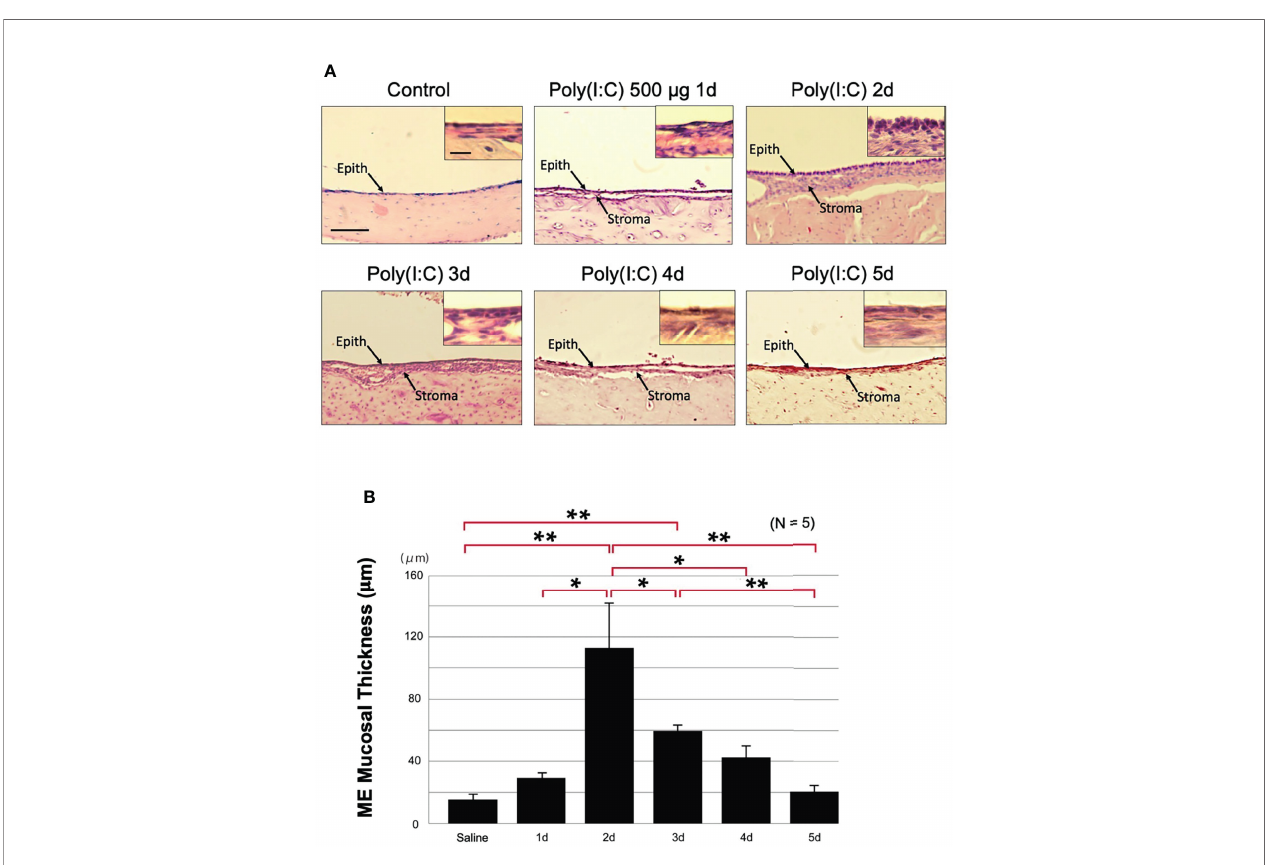
FIGURE 2 | Poly(I:C) enhances rat ME mucosal thickness. (A) Representative microphotographs of rat ME mucosa are shown. Control ME is saline-injected at 2 days. Mucosal thickness is maximal 2 days after administration of 500 m g of Poly(I:C) then gradually recovers, becoming similar to the control on day 5. Scale bars: 100 m m for main image, 25 m m for insert (B) Morphometrically measured mucosal thickness con fi rms increase to a maximum at day 2 after administration of Poly(I:C), then a gradual decrease to the control level by day 5. N refers to number of MEs. *p < 0.05; **p <